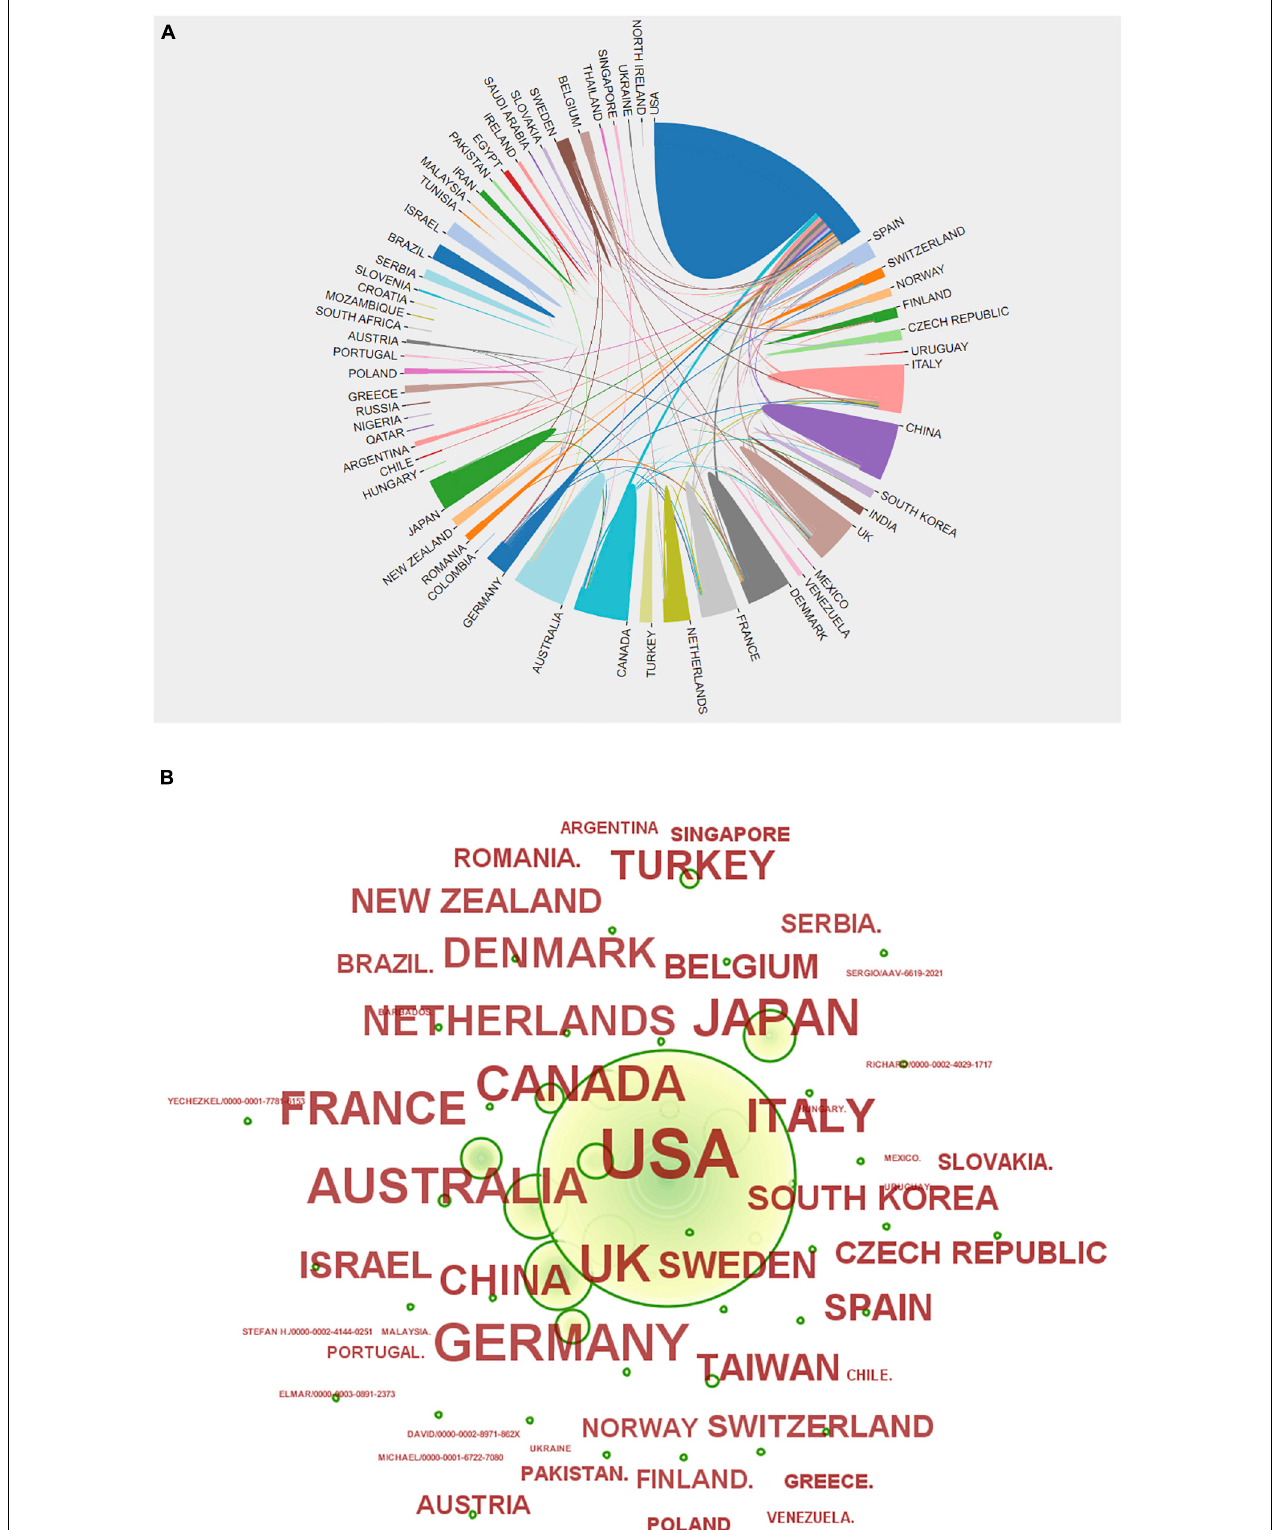
FIGURE 3 | (A) Country network visualization showing connections among countries. (B) Various countries’ issuance status.